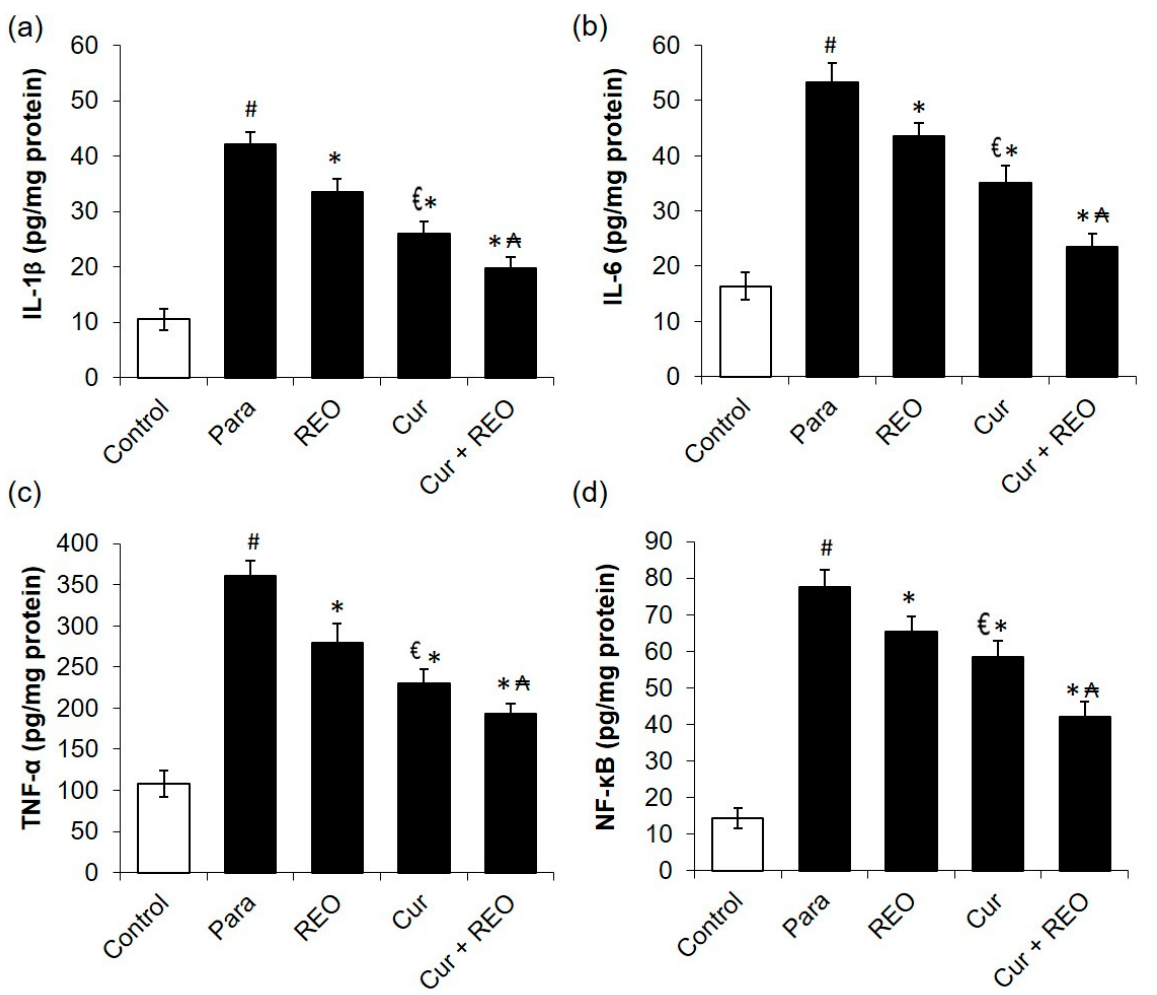
Figure 5. The effect of pretreatment with curcumin (Cur) and rosemary essential oil (REO) on hepatic homogenate of ( a ) IL-1 β , ( b ) IL-6, ( c ) TNF- α and ( d ) NF- κ B activities in paracetamol (Para) induced liver toxicity in mice. Each column represents the mean ± SD ( n = 6). The symbol # designates statistically significant compared to the control group, * defines statistically significant compared to the Para group ( p < 0.05), € describes statistically significant compared to the REO group ( p < 0.05), and ₳ designates and followed by Tukey’s post hoc